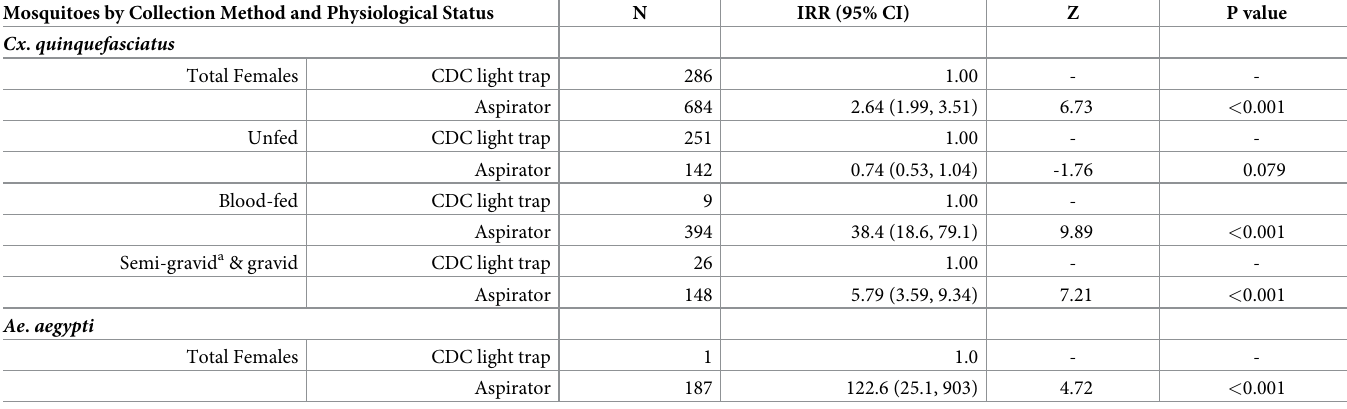
Table 1. CMC study: Number of female Cx . quinquefasciatus and Ae . aegypti mosquitoes collected, with physiological status ( Cx . quinquefasciatus ), incidence rate ratio (IRR), and models for Cx . quinquefasciatus including collection method and adjusted by house, day, and week, Sı´tio Novo, Olinda, RMR, Brazil, July 22– August 21, 2015. Each pair of rows is a separate analysis.